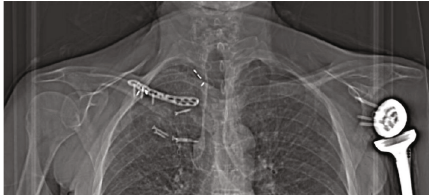
Figure 4: Five months post-ORIF. Scout view of a CT scan illustrating hardware migration and displaced comminuted bone